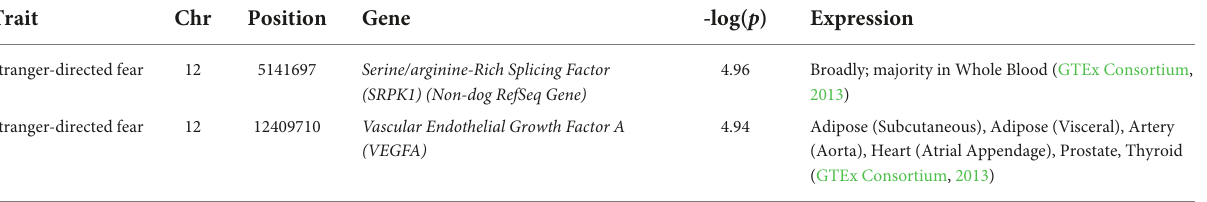
TABLE 2 Association studies of individual Loci (Manhattan